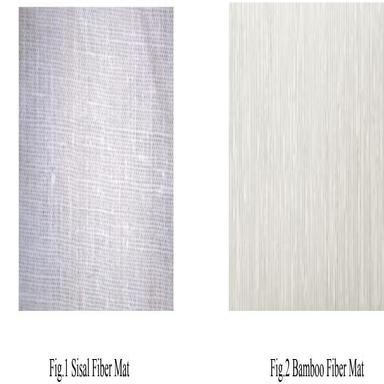
mp Fiber Mat Fig.4 Sugar Tree Fiber Mat